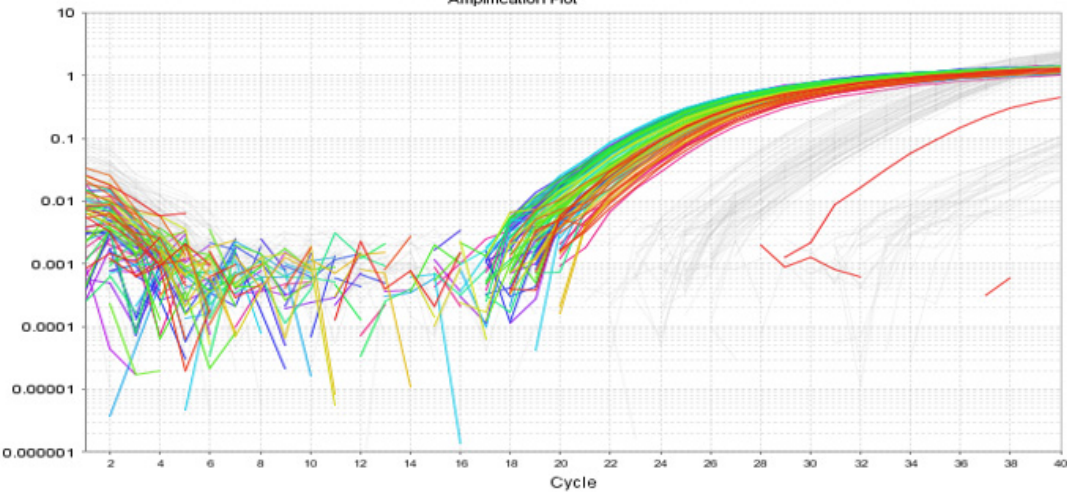
Figure 16. Amplification plots for PPAR β / δ gene expression in the right and left BLA.